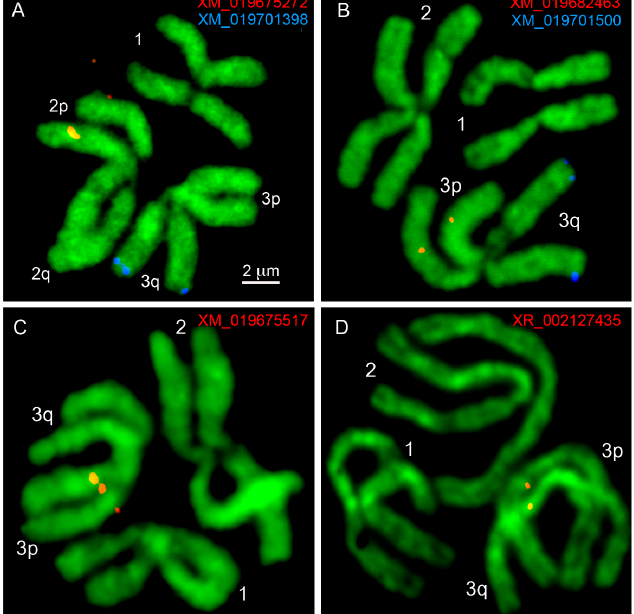
Figure 2. Examples of FISH in mitotic chromosomes of Ae. albopictus. The locations of transcripts XM_019675272 and XM_019701398 ( A ); XM_019682463 and XM_019701500 ( B ); XM_019675517 ( C ); and XR_002127435 ( D ) are shown. Chromosomes and chromosome arms are indicated by the numbers 1, 2, and 3 and the letters p and q, respectively. Transcripts numbers on the figure are shown with the same color as the probe signals on the chromosomes.